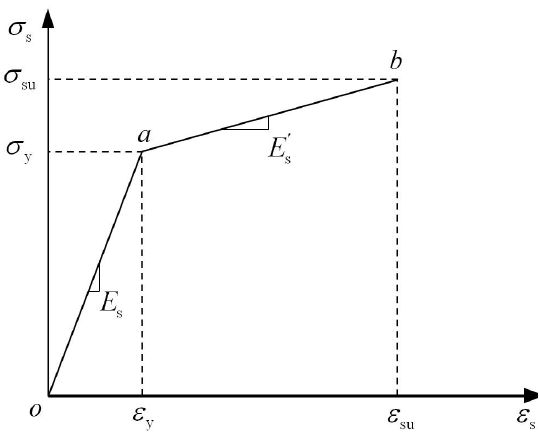
Figure 3. Stress–strain curve of reinforcement.